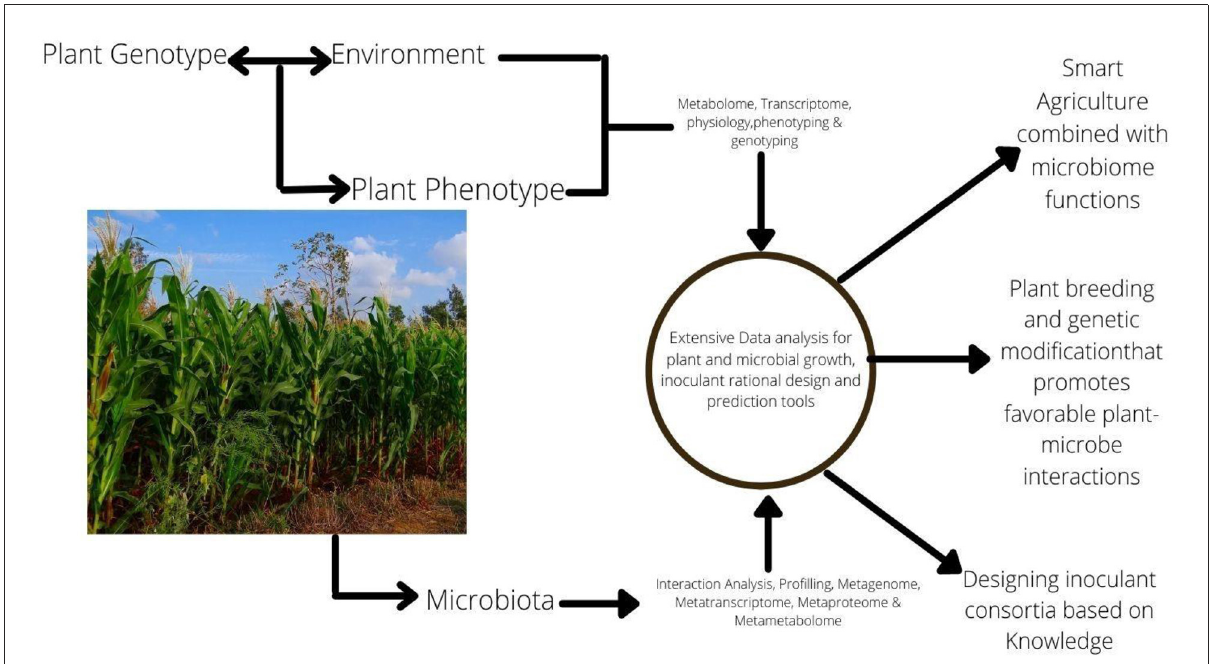
FIGURE1 In-depth knowledge of the interactions of holobiont and their function leads to knowledge-based approaches for microbiome applications. Such as harnessing the potentials of the Plant—Soil—Microbes interaction in (i) the selections of plant type or varieties that favors beneficial plant-microbe interactions, (ii) microbial inoculant complementation, and (iii) agricultural management practices that enrich microbiota with desirable